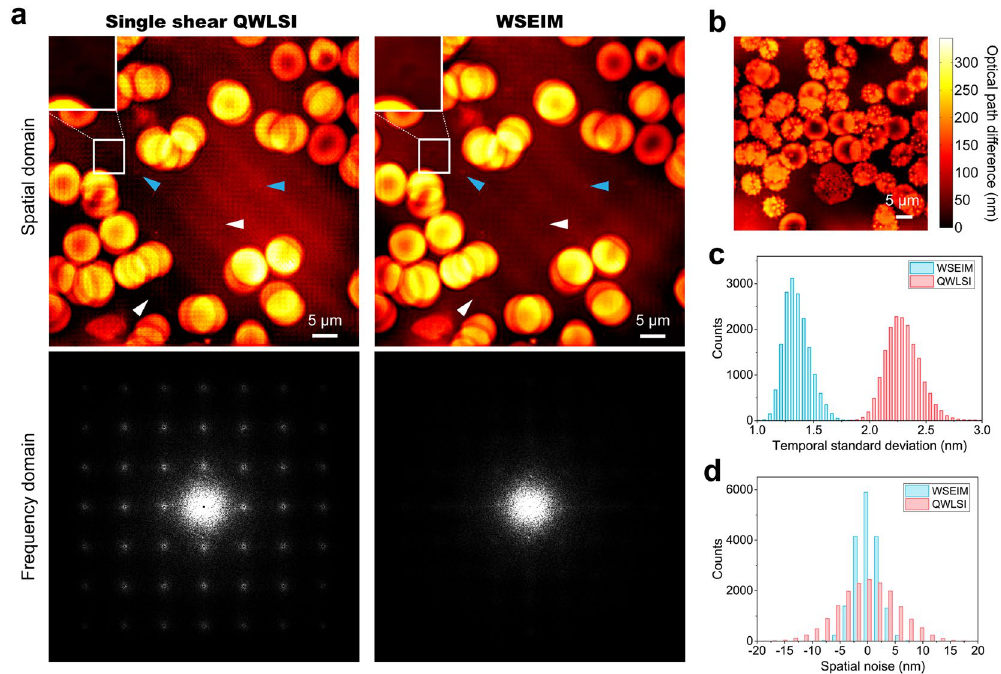
Figure 7. Quantitative phase imaging of RBCs using WSEIM. ( a ) Comparison of the phase imaging results by the single shear QWLSI and the WSEIM. Spatially periodical error emerges in the test result of the single shear QWLSI, as its corresponding Fourier spectrum also has lattice-like errors due to zero measurement sensitivities at these frequencies. Because of wideband sensitivity enhancement, these errors has been eliminated in the test result of the WSEIM. (Insets) A platelet with tiny optical path difference compared with blood plasma is observed by the WSEIM, but it is invisible in the phase image obtained by single shear QWLSI. Blue arrowheads point to the microbes shown in both phase images while white arrowheads point to the microbes only observed in the phase image obtained by the WSEIM. Full time sequence is available as Supplementary video S1. ( b ) Quantitative phase imaging of acanthocytes and a white blood cell to validate the robustness of DLPU algorithm. ( c ) The background standard deviations of the single shear QWLSI and the WSEIM in 20 seconds and ( d ) The spatial noises of the single shear QWLSI and the WSEIM, in which a great improvement in both temporal and spatial SNR can be